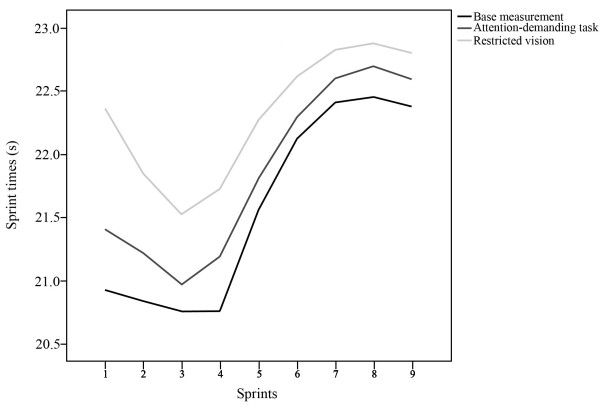
Sprint times during the first test session of a repeated (9 × 30 s) figure-of-eight sprint test with varying rest periods. Group data (N = 19) for the sprint times (s) per test part.